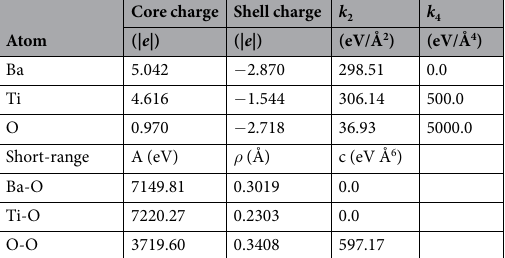
Table 1. BaTiO 3 core-shell model parameters used in this study 28 .